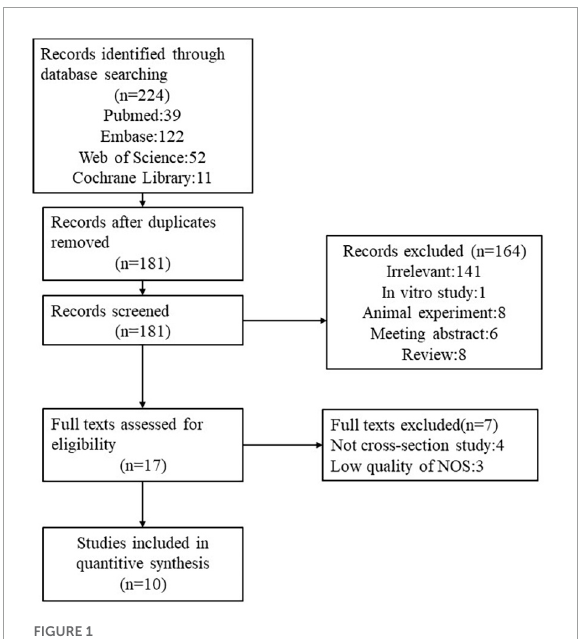
FIGURE1 Flow chart of literature search for studies investigating the association between grip strength and